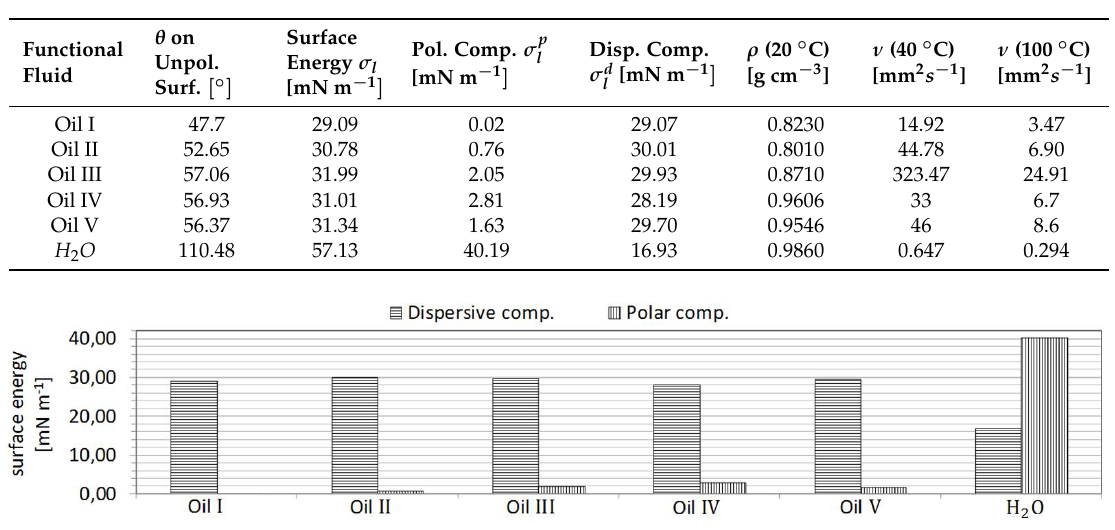
Figure 3. Measured components of surface tension of functional fluids.